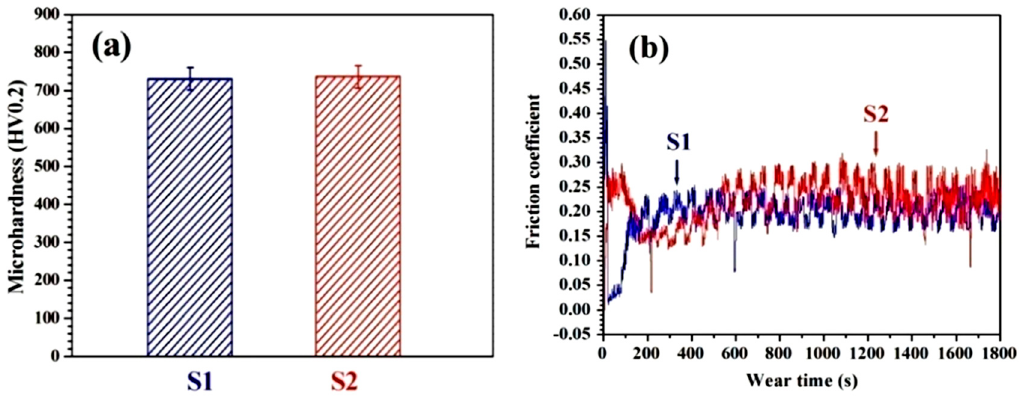
Figure 5. ( a ) The average microhardness on the upper surface and ( b ) the friction coefficients of the cladding layers.